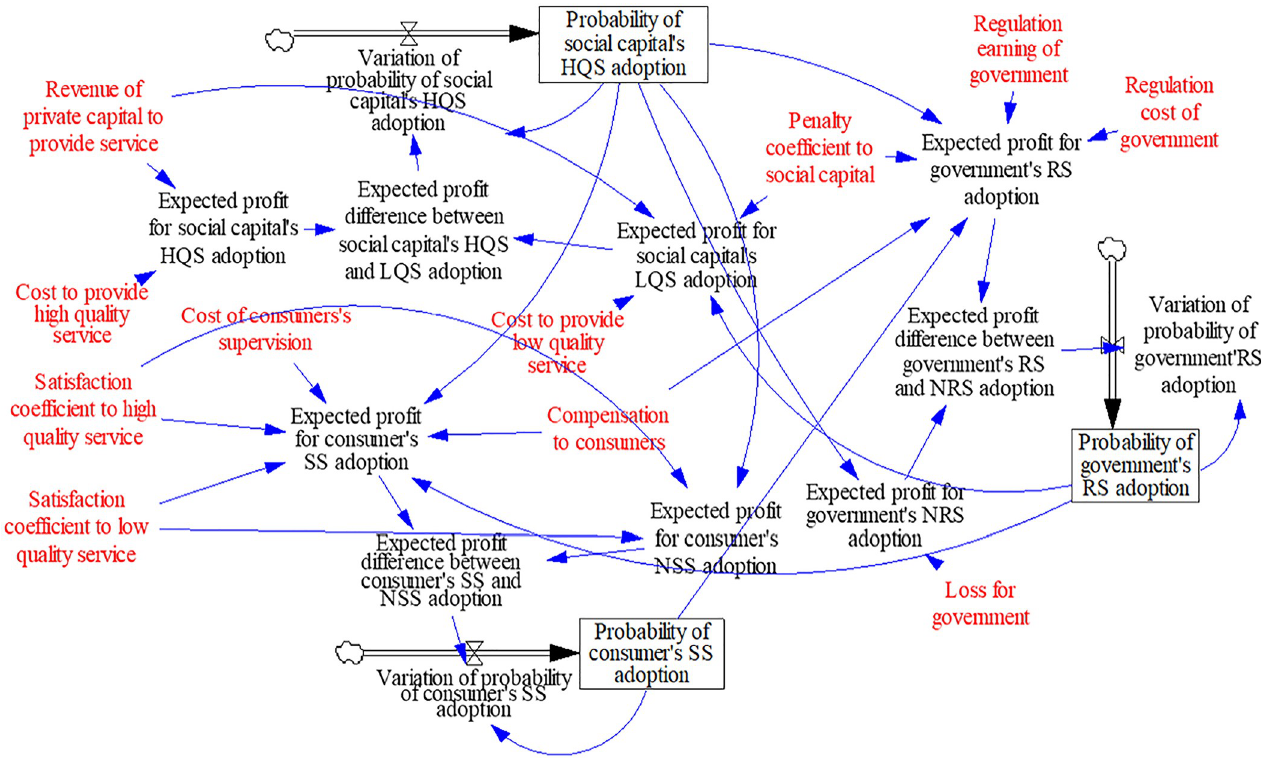
Fig 2. The SD model for social capital, government, consumer in PPP